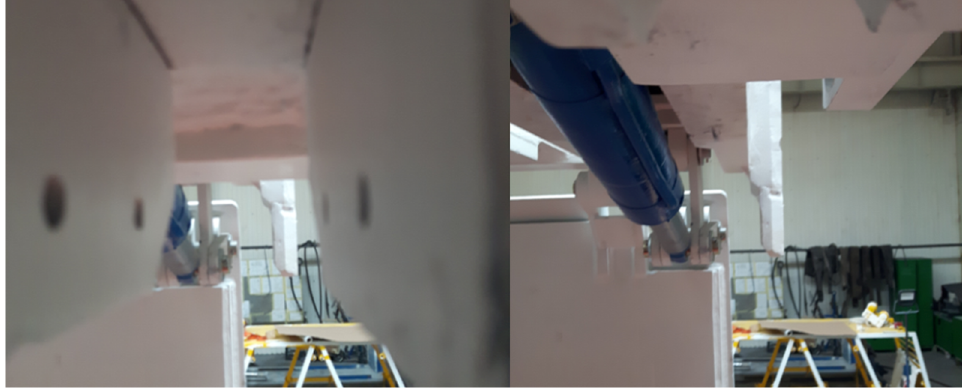
Figure 4. View from SSMS-S sensor located on the BW 24/44 POz roof support.